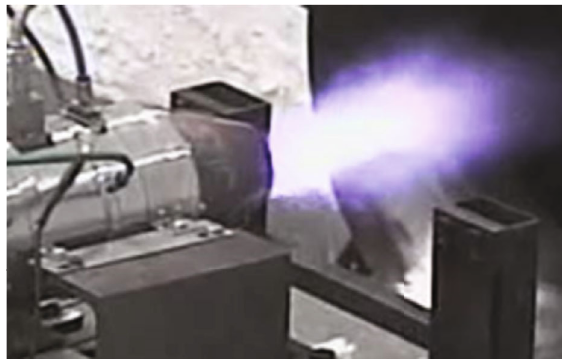
Figure 3: Photo of a whole engine test.